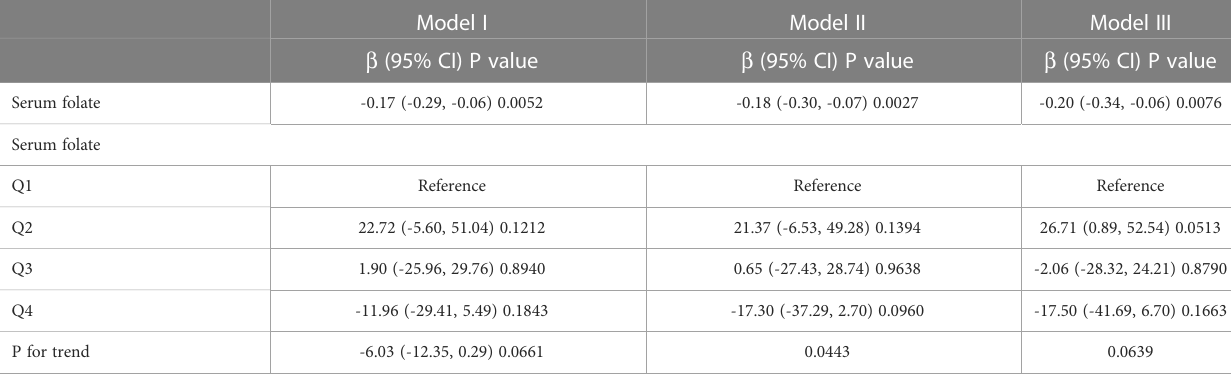
TABLE 2 Multivariate weighted linear regression model analysis elucidates the correlation between the serum folate and blood eosinophils